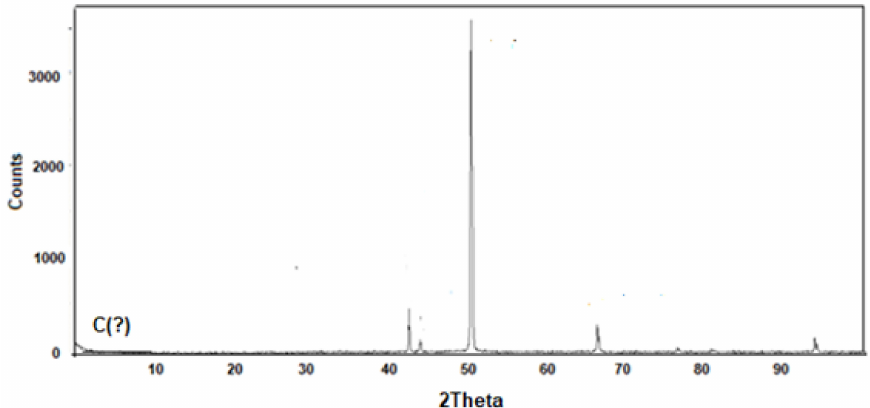
Figure 4. XRD of the composite obtained by electrochemical deposition in a GQD bath. CuK α = 1.5406 A ◦ ; Figure 4 exhibits 2 theta reflections at 43.64 ◦ (269.41), 45.07 ◦ (38.72), 50.83 ◦ (2966.06), 65.47 ◦ (223.97), 74.75 ◦ (33.58), and 90.64 ◦ (128.45), with the